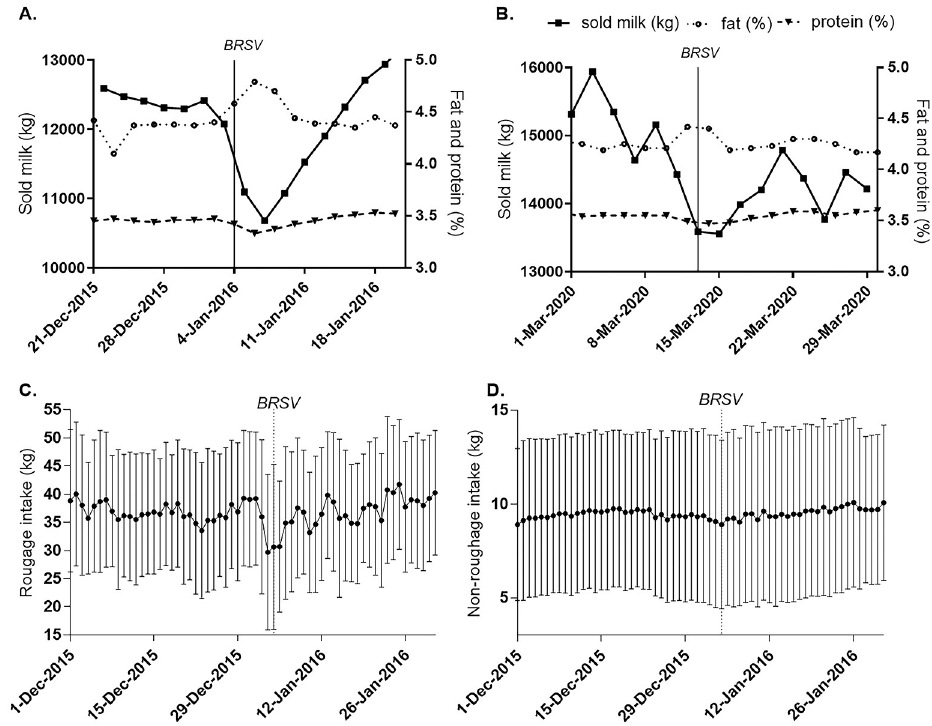
Fig 1. Sold milk, milk composition and feed consumption of cows during BRSV outbreaks in a dairy herd. Weight of sold milk and milk fat and protein composition in (A) 2016 and (B) 2020. Mean ( ± SD) (C) roughage and (D) non- roughage consumption of cows while remaining in production 2016 (i.e. not moved to sick ward). Data on sold milk are expressed as means of two adjacent days.